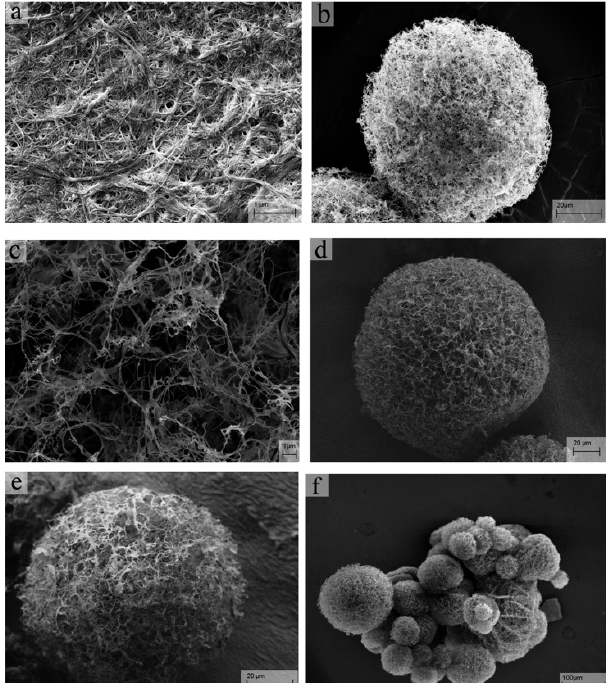
Figure 3. SEM of the aerogel microspheres with a di ff erent cellulose nanofibril concentrations or cross-linker ratios (cellulose nanofibrils to cross-linker, w / w ): ( a ) image of native nanofibrils (scale bar 1 µ m); ( b ) image of aerogel microspheres with a nanofibril concentration of 1.5% and a cross-linker ratio of 10:1 (scale bar 20 µ m); ( c ) image of aerogel microspheres with a nanofibril concentration of 0.6% and a cross-linker ratio of 10:1 at higher magnification (scale bar 1 µ m); ( d ) image of aerogel microspheres with a nanofibril concentration of 2.0% and a cross-linker ratio of 10:1 at higher magnification (scale bar 20 µ m); ( e ) image of aerogel microspheres with a nanofibril concentration of 0.6% and a cross-linker ratio of 10:2 (scale bar 20 µ m); ( f ) low-magnification image shows multiple cellulose nanofibril aerogel microspheres (scale bar 100 µ m). (Reprinted with permission from